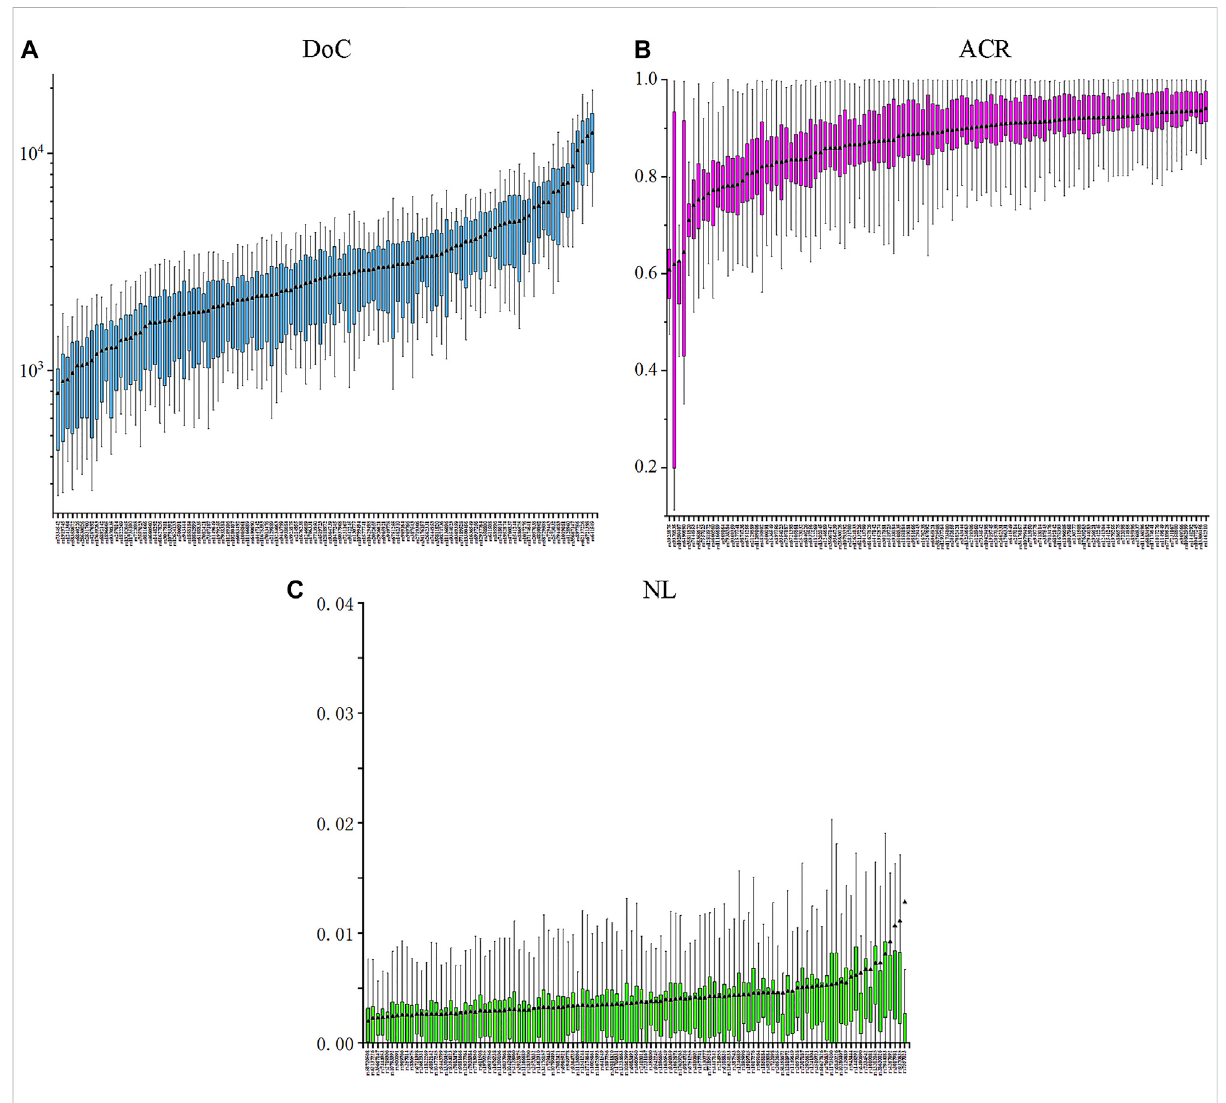
Bonferroni correction. The results of LD tests at 111 II-SNPs are revealed in Supplementary Table S4. As illustrated in Supplementary Figure S1, the allelic frequencies of bi-allelic SNPs and multi-allelic SNPs of the 111 II-SNPs were in the range from 0.2941 to 0.7059, and 0.0080 to 0.6283, respectively. The allele frequency distributions of most bi-allelic SNPs were from 0.4 to 0.6. In Supplementary Figure S3 and Supplementary Table S5, the forensic parameters including PIC, Ho, He, PM, PD, and PE values of the 111 II-SNPs ranged from